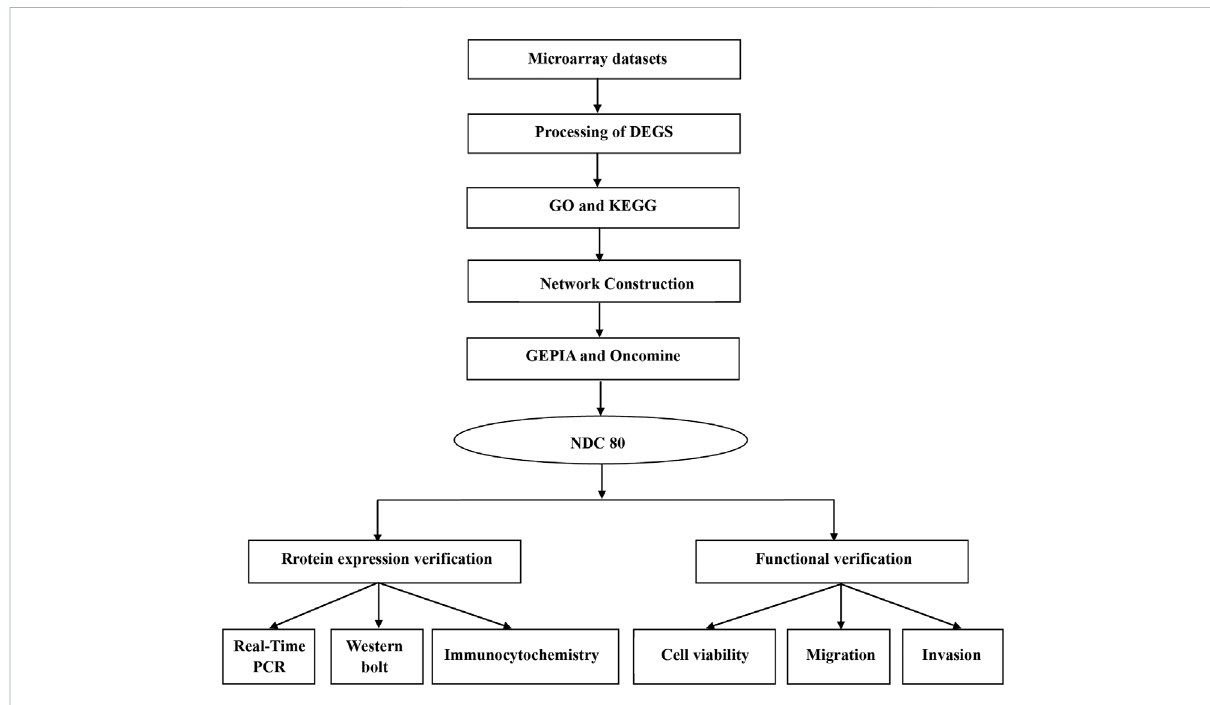
FIGURE 1 Work fl ow chart to better represent the analyses performed and to link some of the methods across the fi elds in this